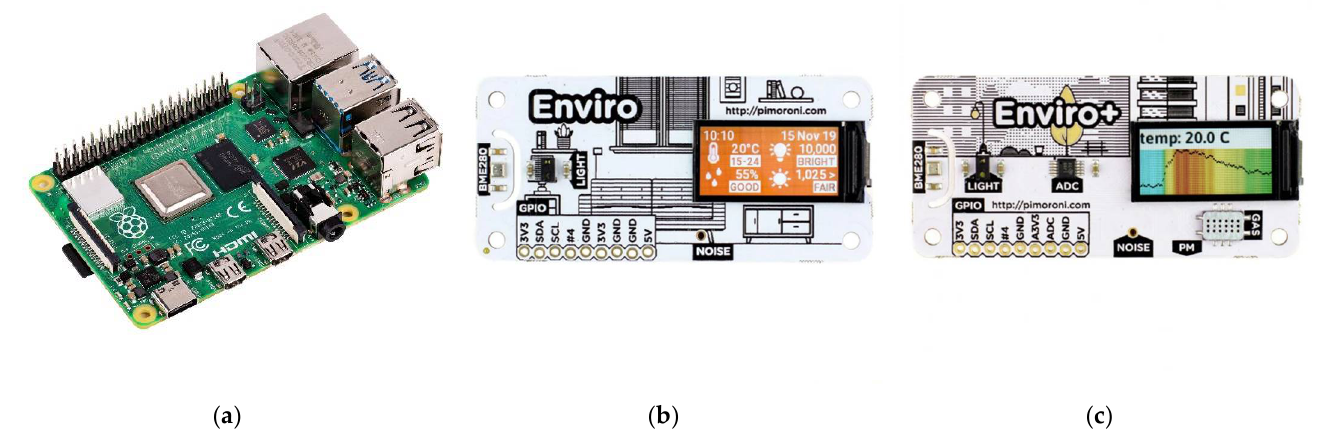
Figure 5. Indoor and outdoor Ambiental monitoring equipment: ( a ) Raspberry 4 Model B single board computer; ( b ) Pimoroni Enviro sensor board; ( c ) Pimoroni Enviro+ sensor board.